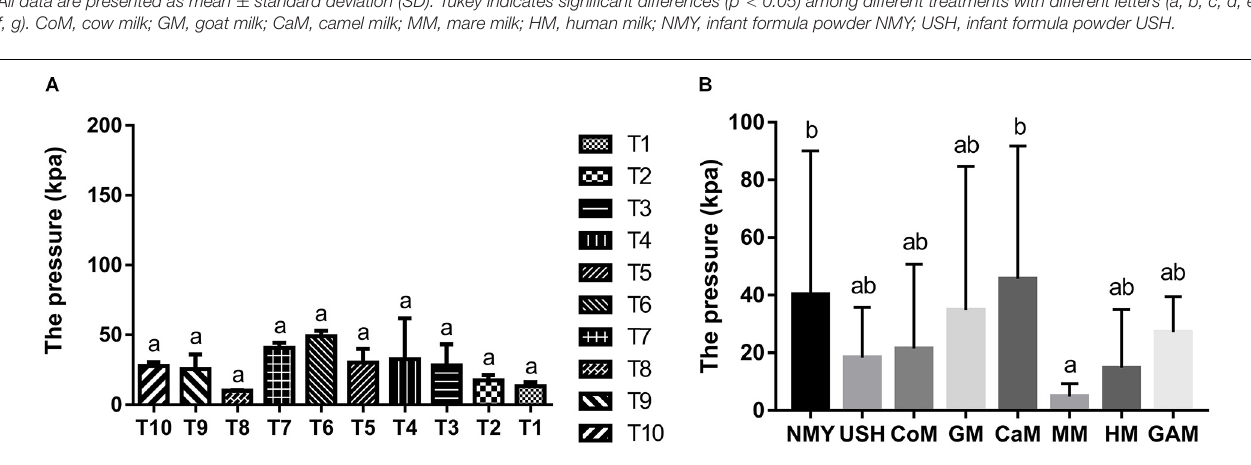
FIGURE 1 | Gas pressure of the ten infant fecal slurry samples fermented with the Gifu anaerobic medium (A) , and Gas pressure of fermented groups (B) . Data are represented as mean ± SD. a , b Means with different letters differ significantly among the groups ( p < 0.05). NMY and USH, infant formula powder; CoM, cow milk; GM, goat milk; CaM, camel milk; MM, mare milk; HM, human milk; GAM, Gifu anaerobic medium.